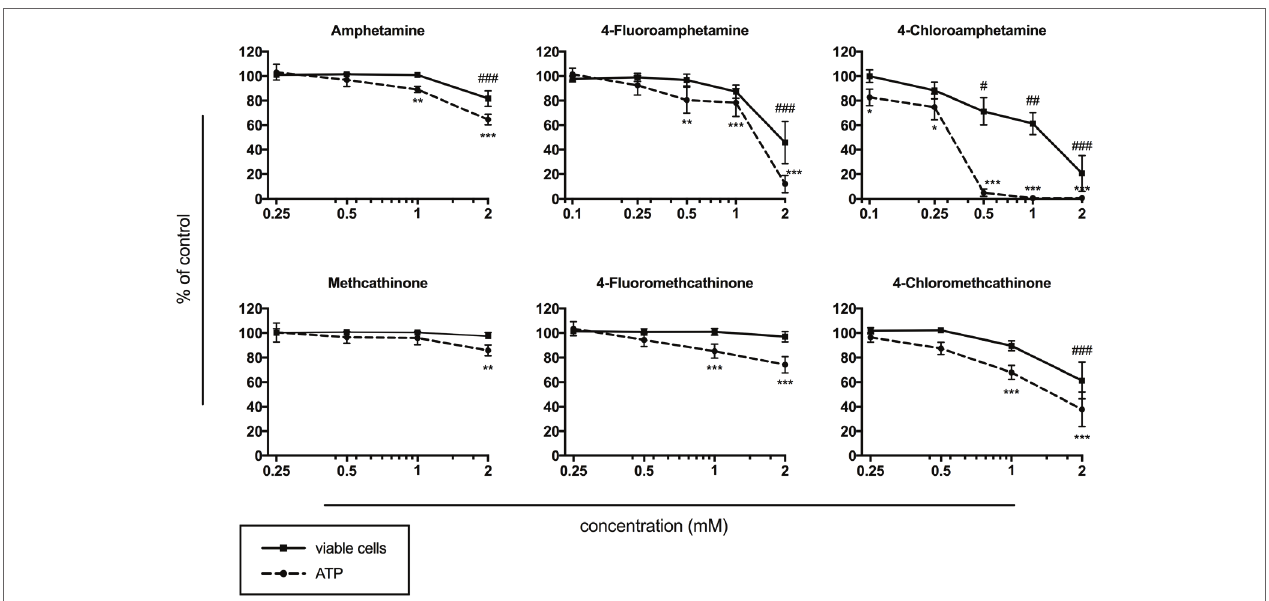
FIGURE 3 | Intracellular ATP content and viable cells expressed by maintained cell membrane integrity after drug exposure of HepG2 cells for 24 h. Data are expressed as mean ± SEM, and numbers in parentheses indicate the number of individual experiments performed in triplicate: amphetamine (4), 4-fluoroamphetamine (7), 4-chloroamphetamine (4), methcathinone (4), 4-fluoromethcathinone (4), and 4-chloromethcathinone (4). Significance levels are given as * p < 0.05, ** p < 0.01, *** p < 0.001 (ATP content); # p < 0.05, ## p < 0.01, ### p < 0.001 (viable